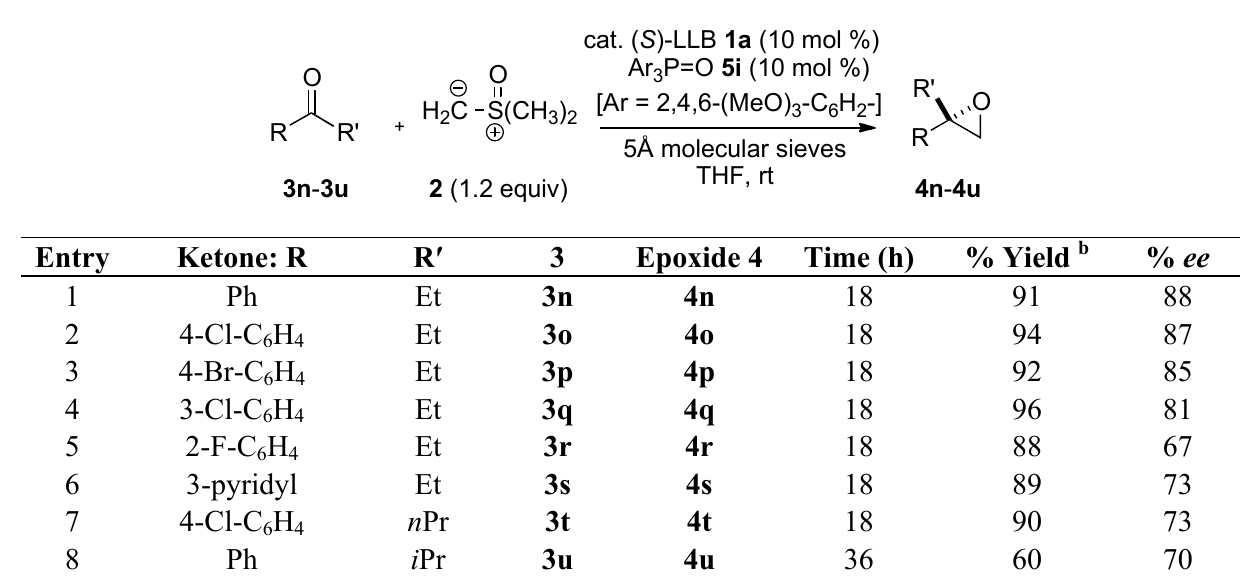
Table 3. Catalytic asymmetric synthesis of 2,2-disubstituted terminal epoxides from other ketones a